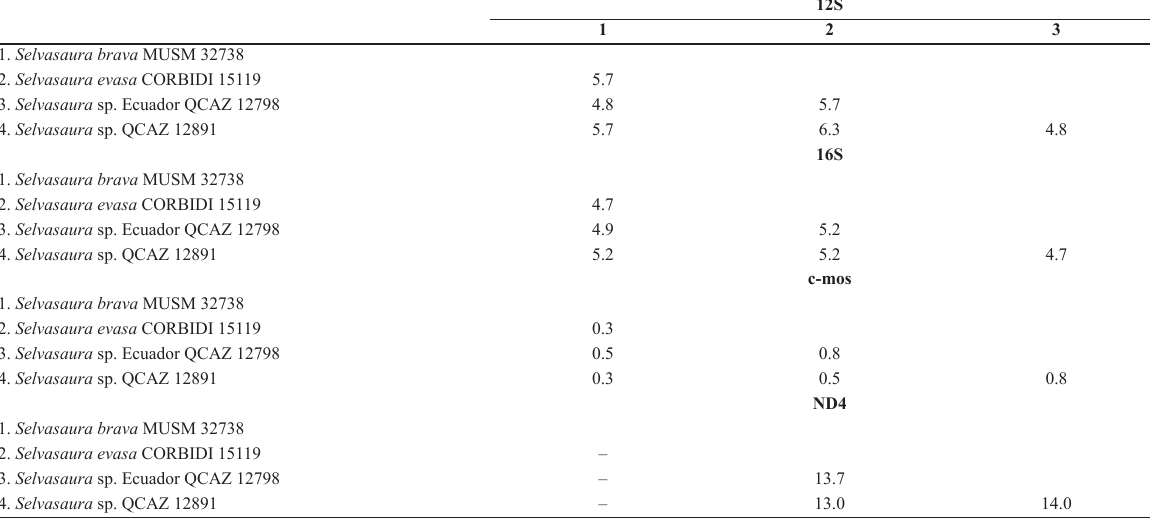
Table A1. Uncorrected genetic distances for 12S, 16S, c-mos, and ND4 within Selvasaura